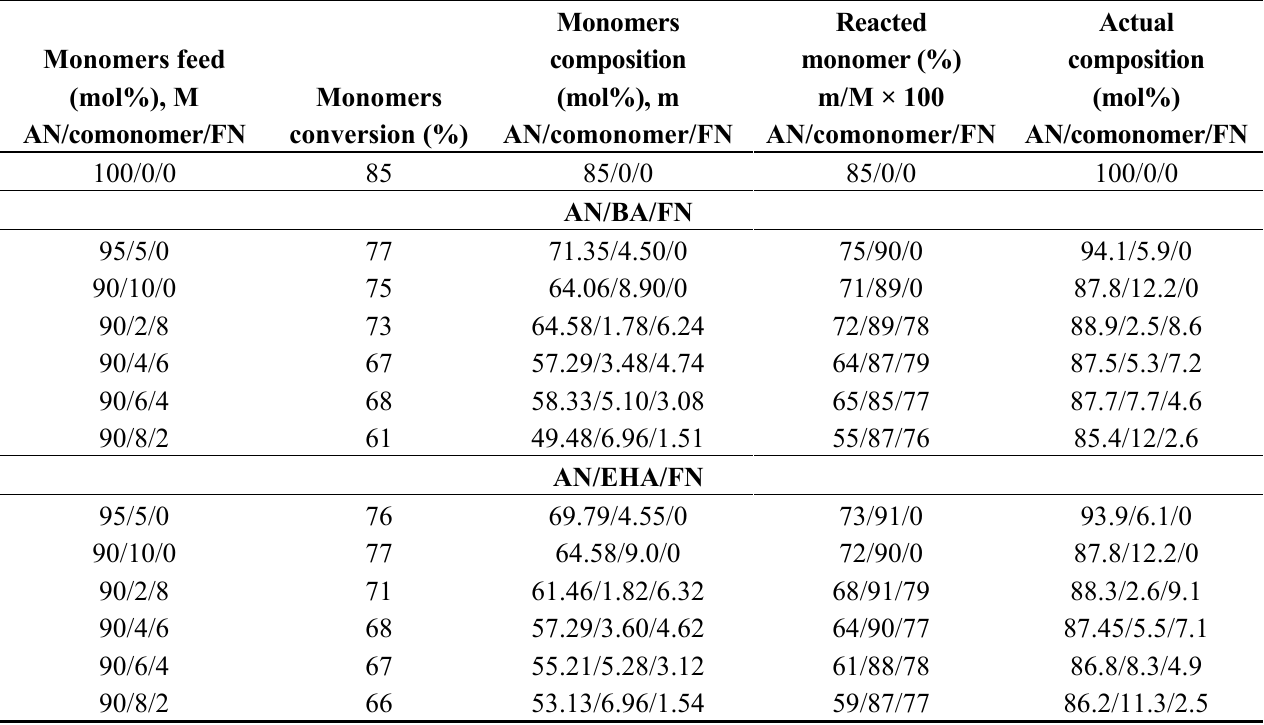
Table 1. Composition of reacted monomers in polyacrylonitrile (PAN) homopolymer, copolymer and